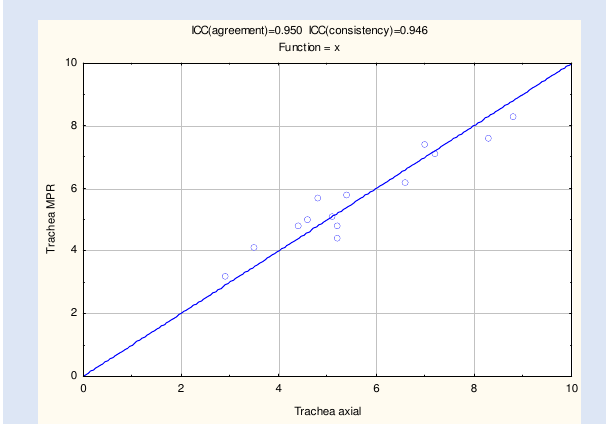
Graph 1. Comparison of axial measurements v. measurements after MPR in the trachea. Graph 2. Comparison of axial measurements v. measurements after MPR in the right main bronchus.